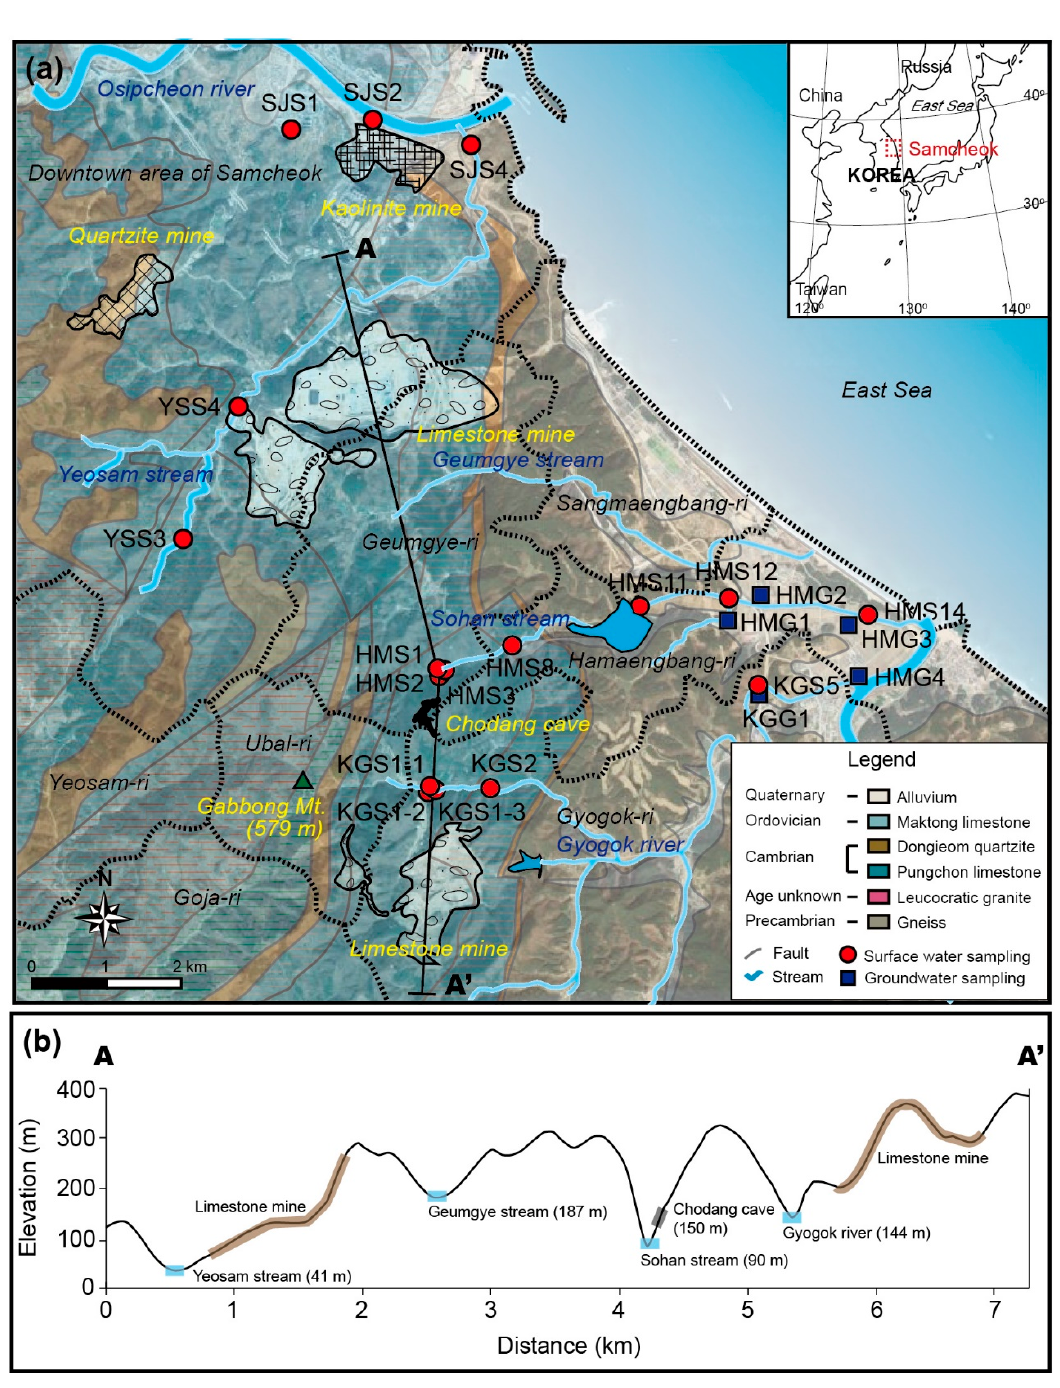
Figure 1. ( a ) Location and simplified map of the study area with water sampling locations; ( b ) cross-sectional view showing the elevation of the study area.